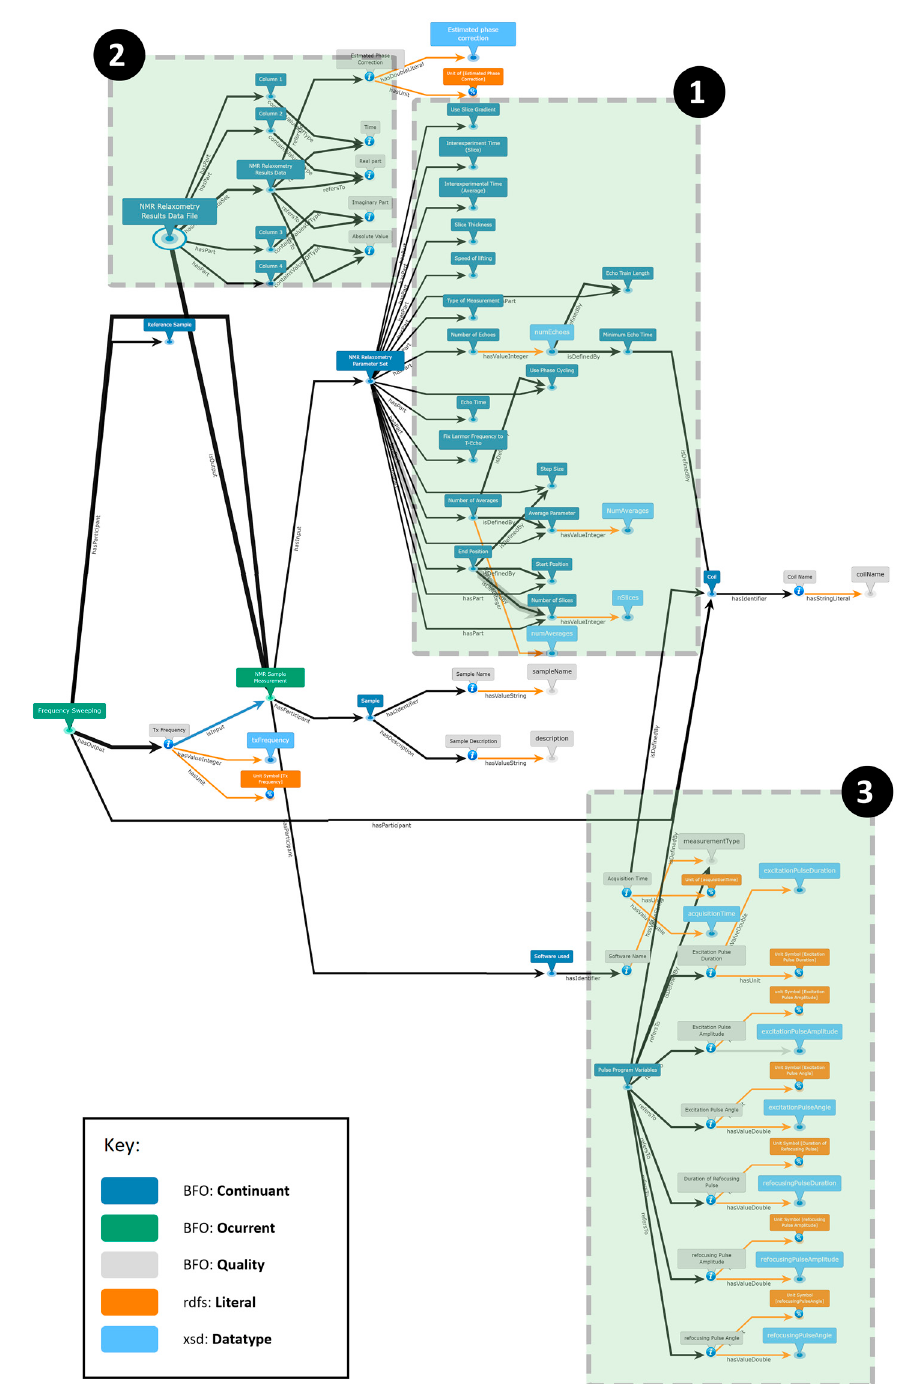
Figure 9. Graphical representation of the knowledge base created from the 1 H NMR relaxometry test for humidity detection and porosity distribution. Some entities have been collapsed for better visualization. In the key the color codes are shown as encoded in the BWMD ontology file [105]. The shaded area 1 corresponds to the description of the content in the metadata file (zoom in Appendix A Figure A1). The shaded area 2 corresponds to the description of the results data file (zoom in Appendix A Figure A2). The shaded area 3 is a non ‐ collapsed subset of area 1 that corresponds to the description of six variables of the NMR measurement used by the measurement machine software (zoom in Appendix A Figure A3). It can be observed how each Quality is match to a xsd:Datatype (where the type of data to be stored is defined) and a rdfs:Literal (where the value of the Quality is stored).